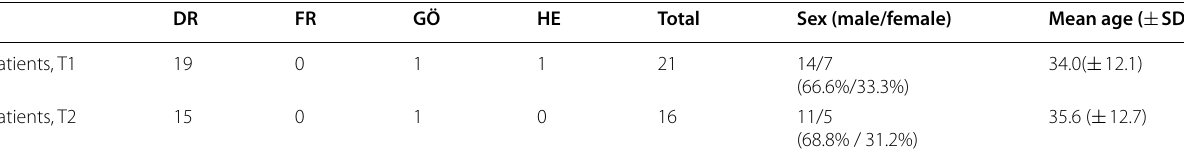
Table 4 Project B2: Subjects’ characteristics (sex, age)